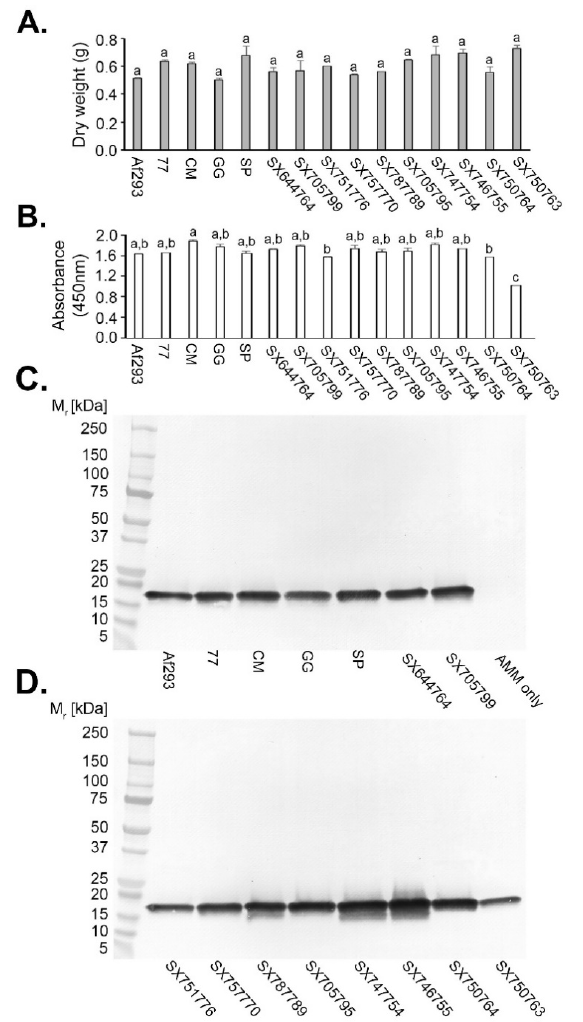
Figure 4. Production of the PD7-reactive 18 kDa ribotoxin by different strains of A. fumigatus . All 14 strains were isolated from naturally-infested soils, and protein precipitates were prepared from 72-h-old AMM shake cultures. A. fumigatus Af293 acted as the positive control, while AMM only acted as the negative control. ( A ) Dry weights of strains after 72 h growth, showing no significant differences in weights compared to Af293. ( B ) While the mean absorbance value for strain SX750763 was significantly reduced in the Afu -ELISA ® , an 18 kDa PD7-reactive band was present in all protein precipitates ( C , D ), with the exception of the negative control. Bars in ( A , B ) are the means of three replicate values ± SE, and bars with the same letter are not significantly different at p < 0.05. The threshold absorbance value for detection of ribotoxin protein in the Afu -ELISA ® ( B ) is ≥